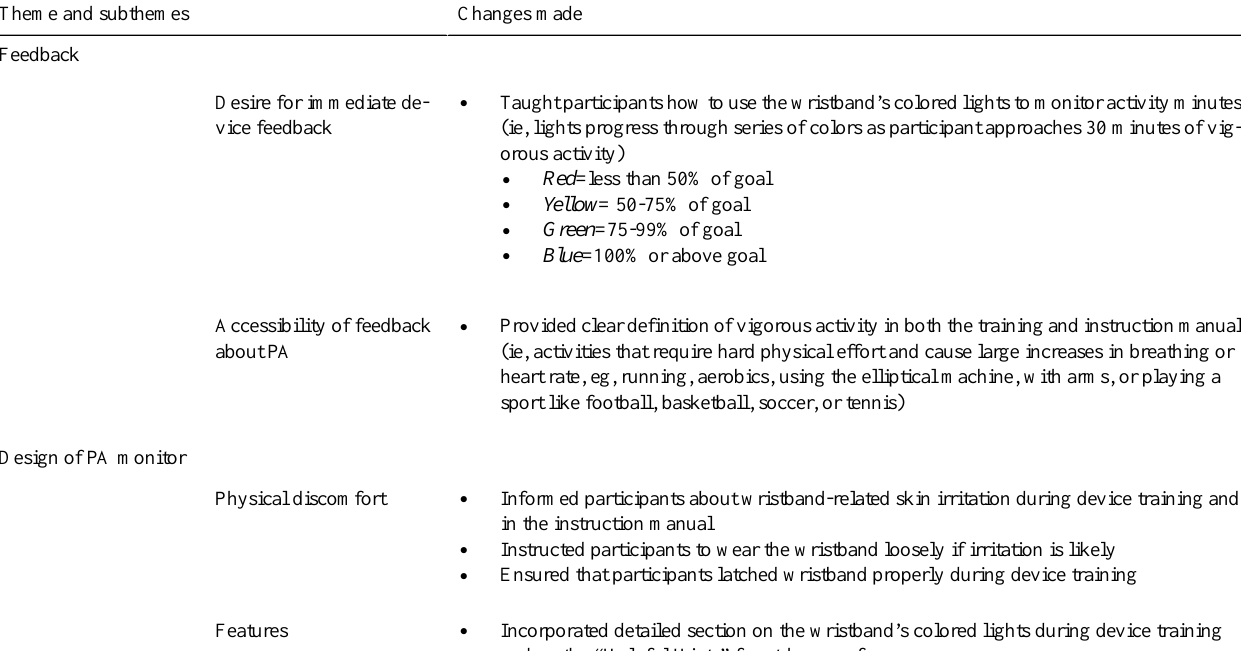
Table 3. Lessons learned and changes made for testing PA technology in broader community-based